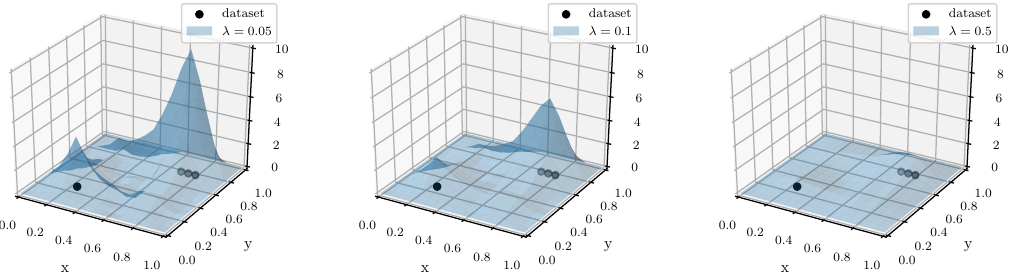
Figure 4. The effect of the regularization parameter λ on a 2-D dataset with four data points. For smaller λ values, the function becomes more similar to the initial density guess of Dirac δ functions.